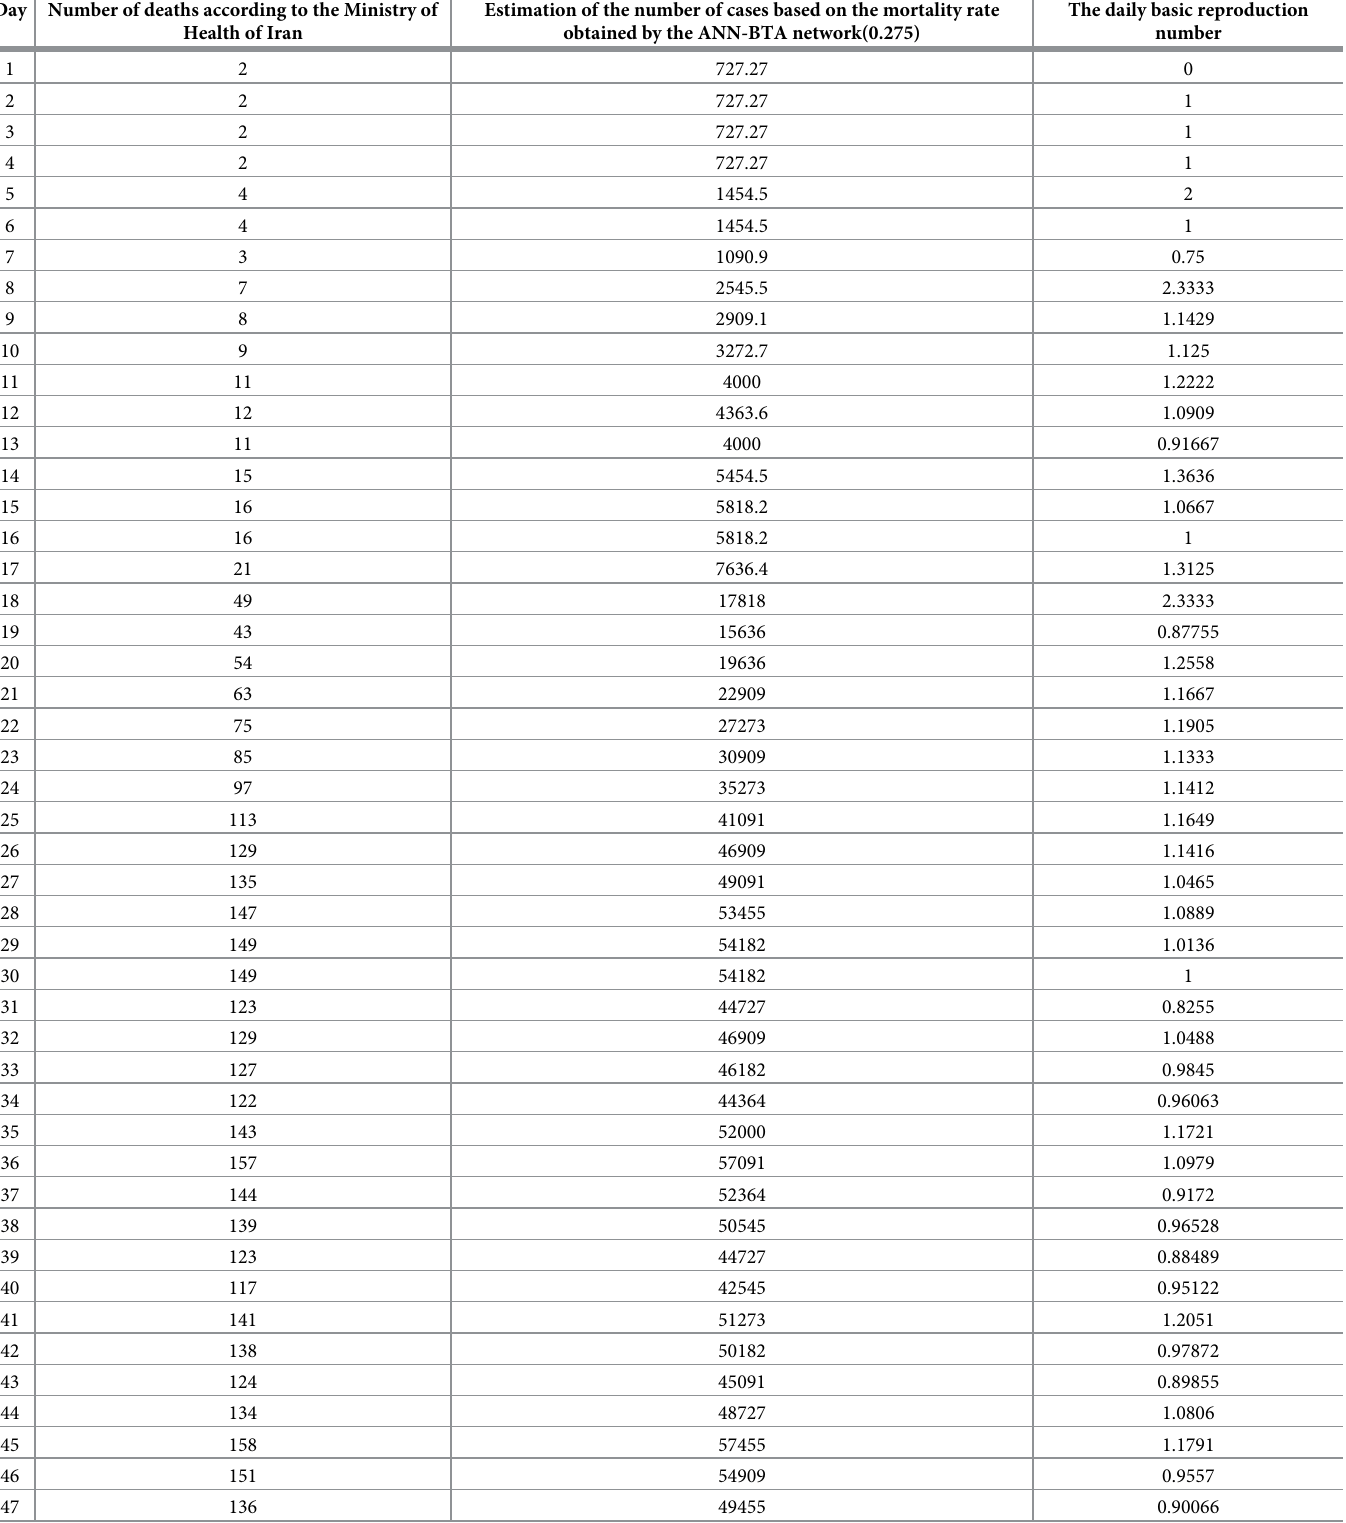
Table 13. Estimation of basic reproduction number and number of patients per day in the period of February 19, 2020 to May 18, 2020 in Iran based on the mortal- ity rate obtained by the ANN-BTA network and the mortality rate declared by the Ministry of Health of Iran. Day Number of deaths according to the Ministry of Health of